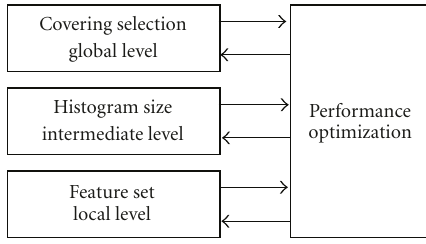
Figure 5: The system architecture